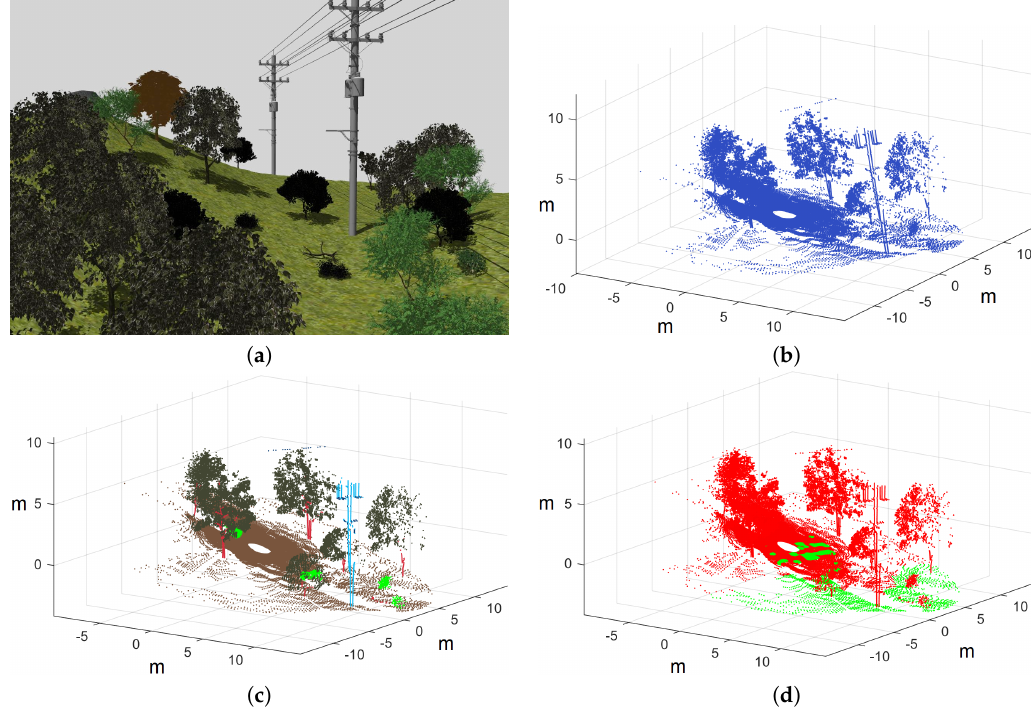
Figure 3. A view of the hills generated with Gazebo ( a ), a synthetic 3D scan taken from this zone ( b ), its gravity-levelled and intensity-tagged point cloud ( c ) and the traversability-labelled 3D data ( d